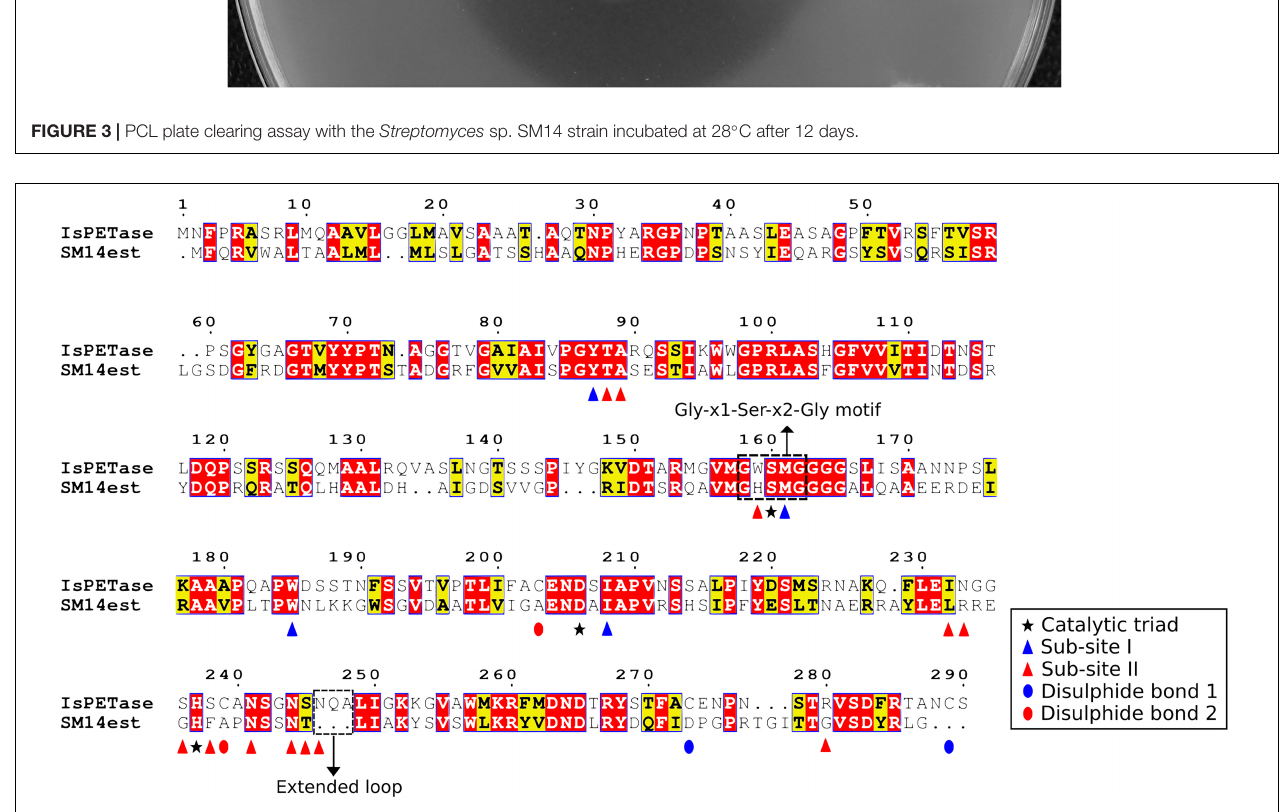
FIGURE 4 | Amino acid sequence alignment of the IsPETase and the SM14est proteins, generated using MEGA X, Muscle, and ESPript 3.0. Identical residues are highlighted in red boxes, and the ones with similar biochemical properties are highlighted in yellow boxes. The serine hydrolase motif Gly-x1-Ser-x2-Gly and the IsPETase extended loop are highlighted in black boxes; the catalytic triad is indicated by a star; the sub-site I and sub-site II are indicated by a blue and a red triangle, respectively. The disulphide bond 1 and disulphide bond 2 are indicated by blue and red ellipses,